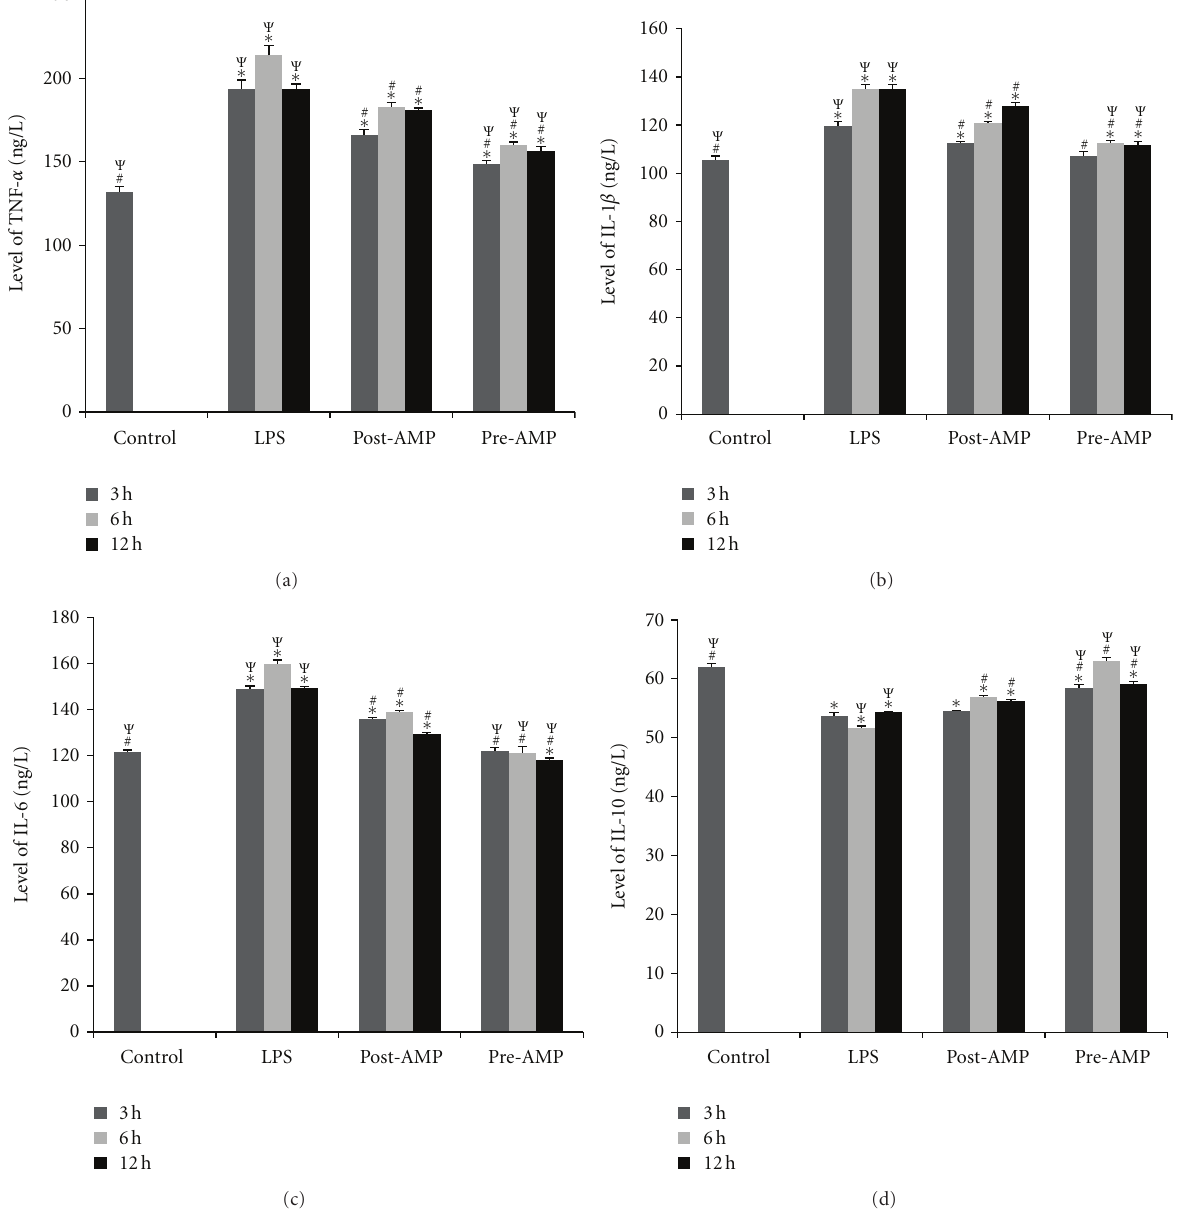
Figure 3: The BALF inflammatory factor levels. The BALF inflammatory factor levels in the rats were measured at 3h, 6h and 12h after LPS injection. (a) TNF- α ; (b) IL-1 β ; (c) IL-6; (d) IL-10. Control group: no treatment; LPS group: endotoxemia rat model induced by LPS; Posttreatment group: endotoxemia rat model treated with 5 (cid:2) -AMP. Pretreatment group: rats pretreated with 5 (cid:2) -AMP prior to LPS treatment. ∗ P < 0 . 05 versus control; # P < 0 . 05 versus LPS; Ψ P < 0 . 05 versus post-AMP.